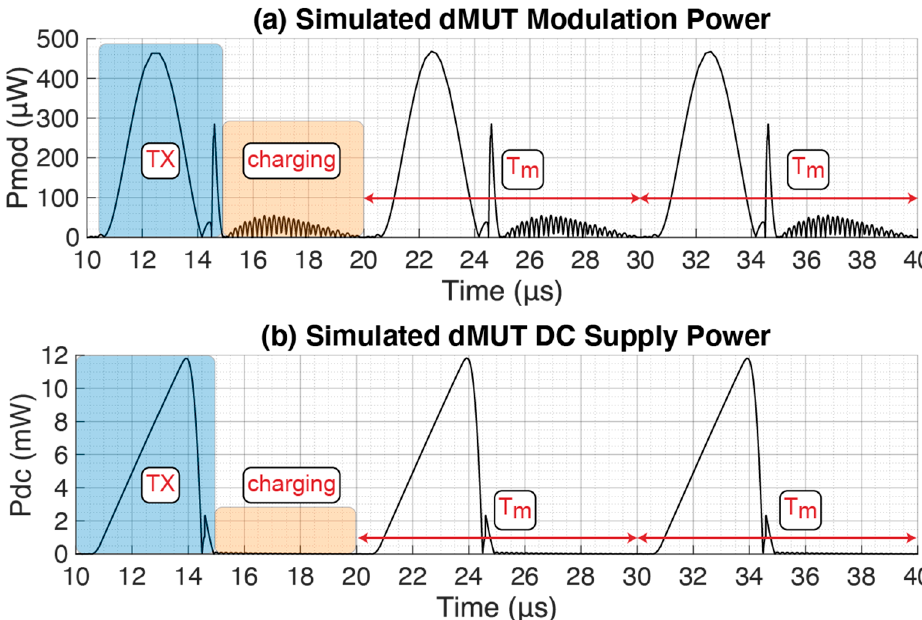
Figure 4. Power consumption of the dMUT system with the values from Table 1. ( a ). Power generated by the AC sinusoidal input modulation signal. ( b ). Power generated by the DC bias voltage signal.